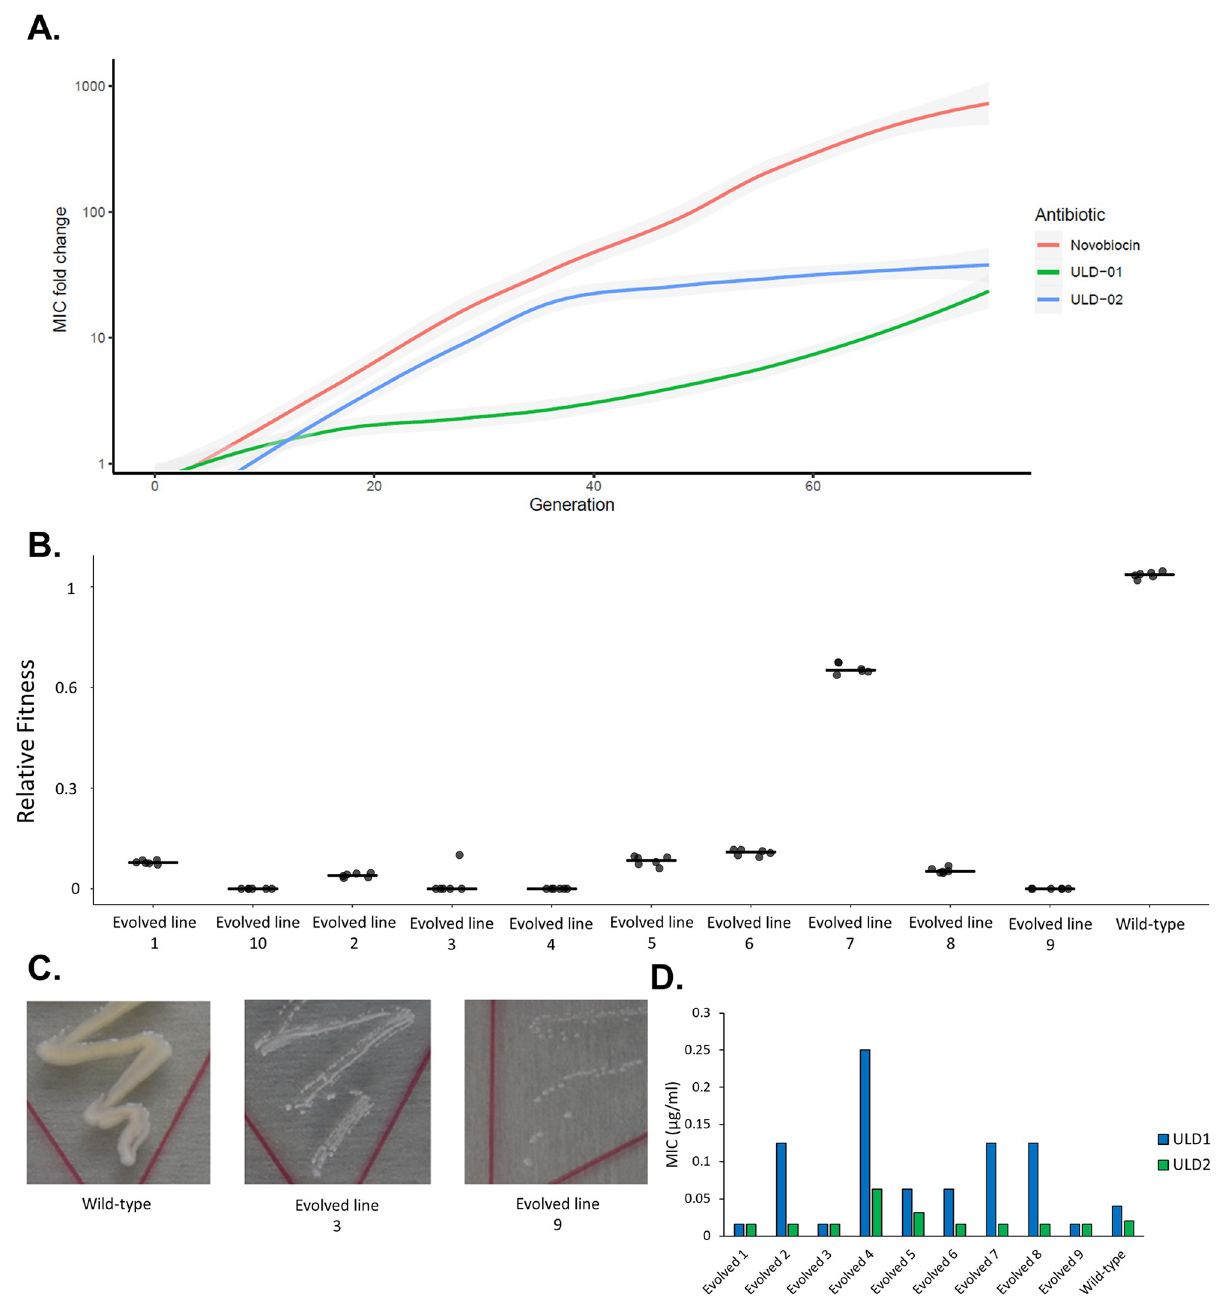
Fig 3. Adaptive laboratory evolution of S . aureus (VISA) ATCC 700699 to ULD1, ULD2, and novobiocin stresses. A. The figure displays increment in MIC level relative to wild type as a function of cell generation number. Data show the mean MIC fold-change based on 10, independently evolving populations. Gray area represents a 95% confidence interval. The underlying data for this figure can be found in S2 Data. B. and C. Relative fitness ( B ) and growth phenotype ( C ) of ULD1-evolved and wild-type S . aureus VISA ATCC 700699. Fitness was approximated from the growth curves of isogenic microbial populations (see Materials and methods) and depicted as relative fitness compared with that of the wild type. Measurements were performed in 6 replicates. The underlying data for this figure can be found in S2 Data. Growth phenotypes were observed in BHI agar plates and documented after 24 hours of incubation at 37 ˚C. D. Susceptibility of novobiocin-resistant S . aureus VISA ATCC 700699 mutants to ULD1 and ULD2. MICs were determined in MHBII medium at 37 ˚C by broth microdilution assay according to CLSI guidelines. One of the independently evolved novobiocin- adapted strains displayed exceedingly slow growth, and therefore, it was omitted from the analysis. The underlying data for this figure can be found in S2 Data. BHI, Brain-Heart-Infusion broth; CLSI, Clinical and Laboratory Standards Institute; MIC, minimum inhibitory concentration; MHBII, Mueller Hinton II Broth; MRSA, methicillin-resistant S . aureus ; VISA, vancomycin-intermediate S . aureus .